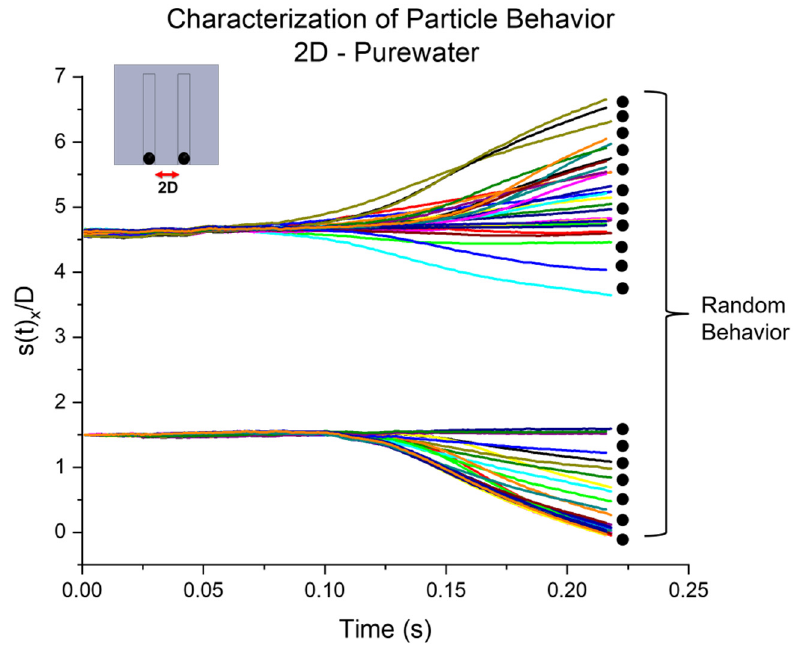
Figure 4. A plot representing particle x displacement normalized by particle diameter as a function of time for thirty repeated experiments at 2D initial separation distance. It demonstrates the random behavior and unstable particle–particle interactions in pure water.